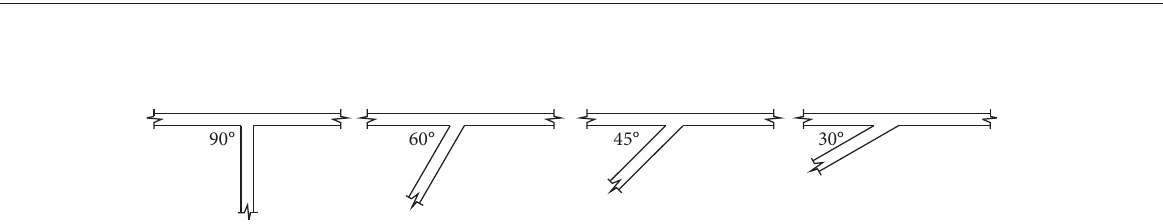
Figure 20: T-shaped connections with different branch angles. Table 10: Parameters of T-shaped connection in different